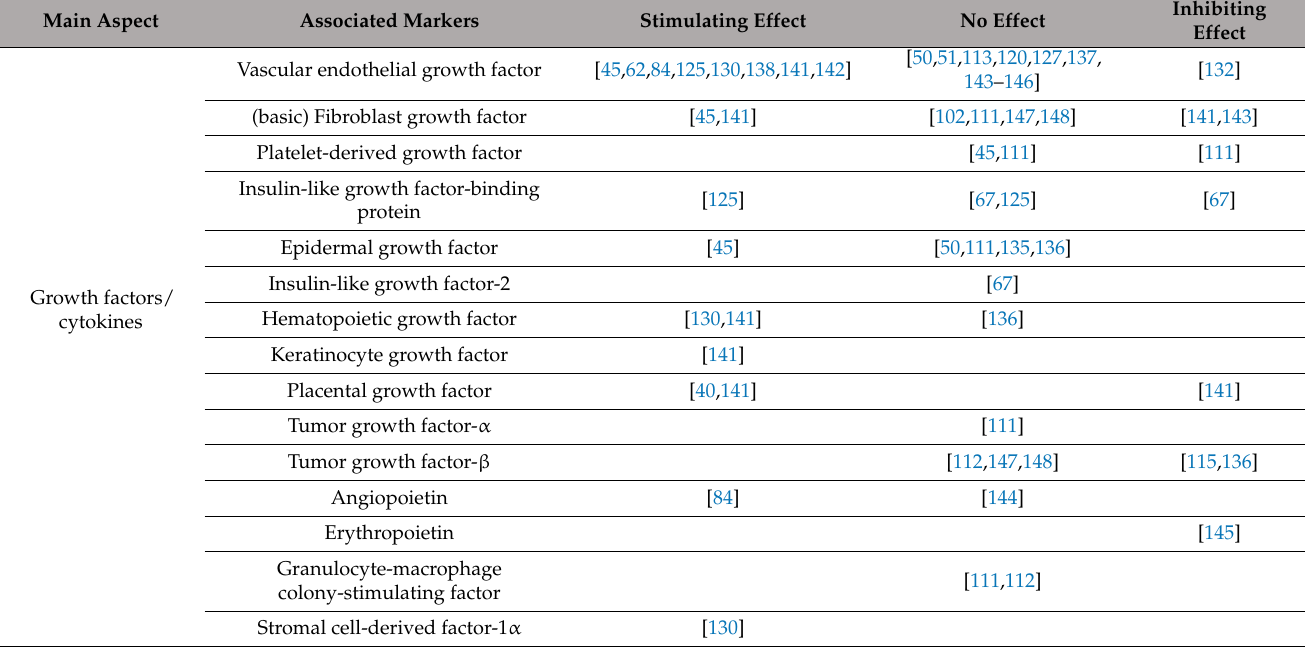
Table 3. The effect of HBOT on angiogenesis